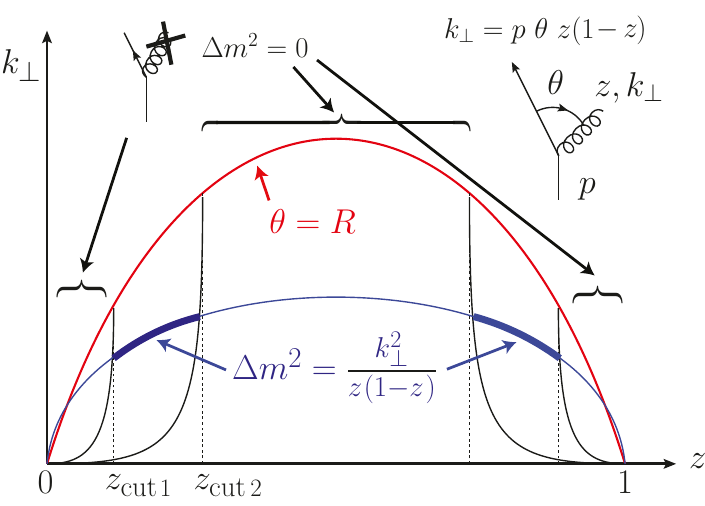
Figure 6 . Single emission phase space regions that are kept and eliminated by collinear drop for the measurement of (cid:1) m 2 . The values of z cut1 and z cut2 are exaggerated for visibility.